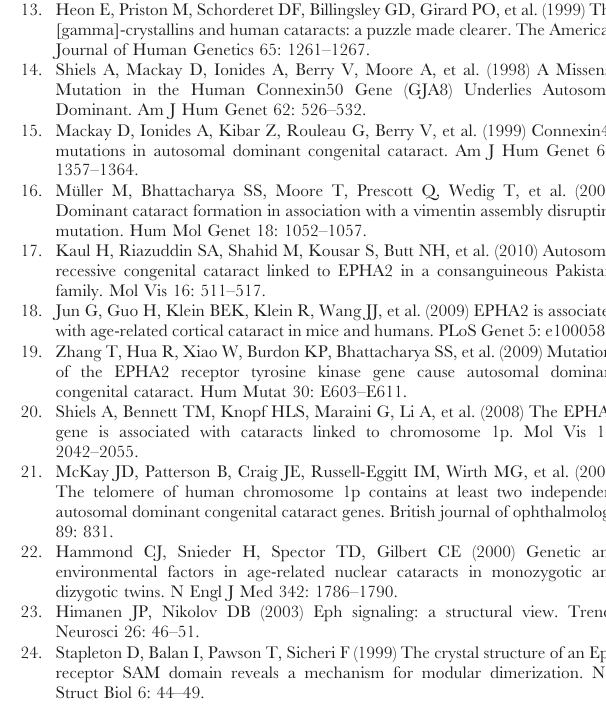
antibodies as described in the Materials and Methods. The blot was reprobed with anti- a -tubulin as a loading control. ( B ) Graphs show EphA2 protein levels over time. Mean values are presented with + S.D as indicated. (TIF) Figure S3 Bafilomycin A1 does not stabilize EPHA2 protein. HEK293T cells were transfected and treated for indicated time with the lysosomal inhibitor bafilomycin A1 (100 nM). Cell lysates were immunoblotted with anti-EphA2 antibody. Lysates were resolved by SDS-PAGE and western blot analysis was performed as described in the Materials and Methods. The blot was reprobed with anti- a -tubulin as a loading control. (TIF) Figure S4 SAM domain of EPHA2 is essential for ligand- independent promotion of cell migration of HEK293A cells. ( A ) EPHA2 SAM domain mutants lack migration promoting activity in HEK293A cells. HEK293A cells were grown to confluence and serum-starved for 24 hours. A scratch wound was made with a micropipette tip and the edge of cells as marked. 2 m g/mL cross-linked ephrin-A5-Fc was then added to the starvation media, and cells were allowed to migrate toward the center of the wound and photographed at the indicated times (representative figure of three independent experiments). The position of the initial scratch is indicated by dotted lines. Scale bar, 500 m m. ( B ) Quantification of EPHA2 genes on HEK293A cell migration. The graphs represent the measurement of migration distance from three independent experiments. Mean values are presented with + S.D as indicated. Statistical differences were analyzed using one-way analysis of variance (ANOVA) or calculated by a two-tailed student t-test. Black asterisks , comparison between time 0 and 24 hours and time 0 and 48 hours; Blue asterisks , comparison between the mock groups and the listed wild-type or mutant EPHA2 genes at 24 or 48 hours; Red asterisks , comparison between untreated and treated